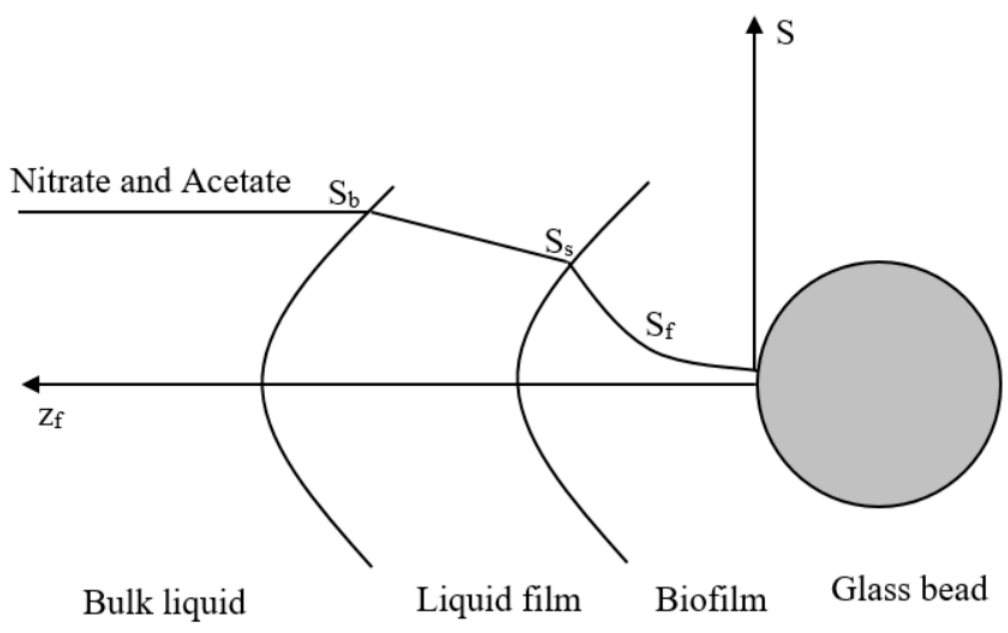
Figure 1. Conceptual model for nitrate and acetate concentration profiles along coordinate system.